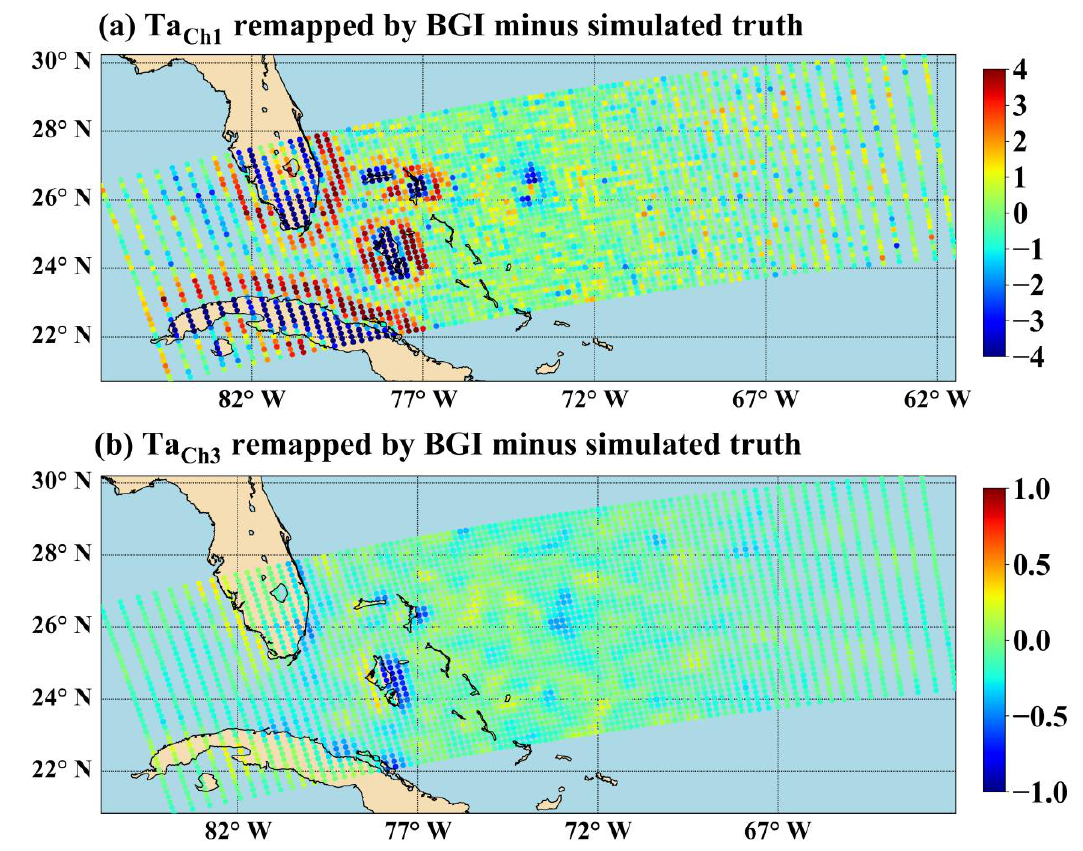
Figure 9. Simulation results of resolution enhancement and degradation by the BGI with the coefficients produced by the Gaussian-shaped antenna pattern for ATMS channels ( a ) 1 and ( b ) 3. Units are K.